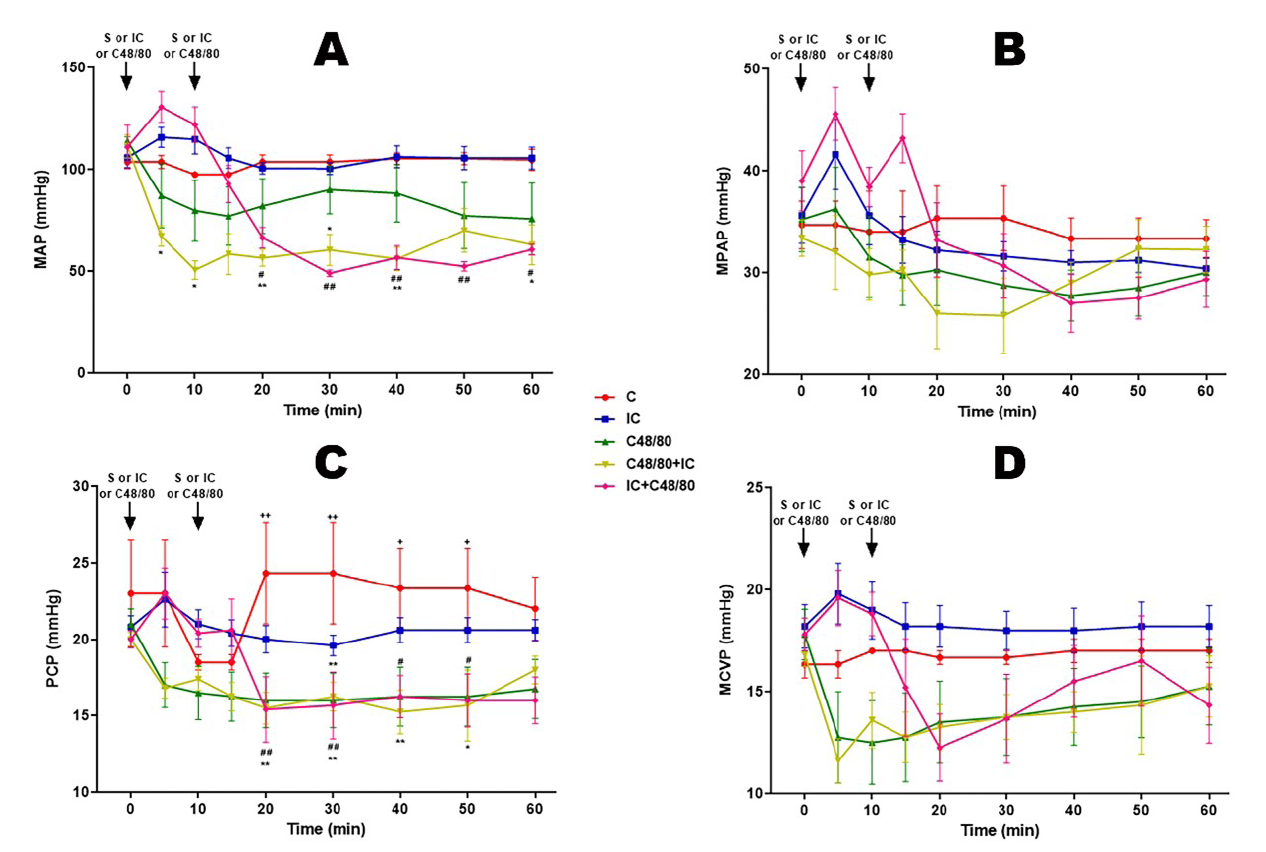
Fig. 1 - Blood pressures. Effect of anaphylactic shock caused by compound 48/80 (C48/80) and treated with indigo carmine (IC) in pigs. A) Mean arterial pressure (MAP); B) mean pulmonary arterial pressure (MPAP); C) pulmonary capillary pressure (PCP); D) mean central venous